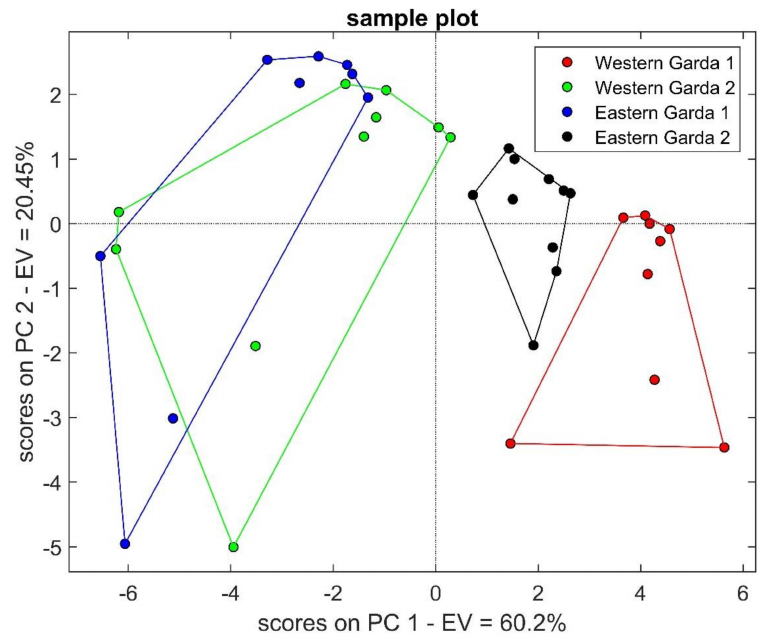
Figure 4. PCA scores plot of phase 2. PC1 variance = 60.2%, PC2 variance =